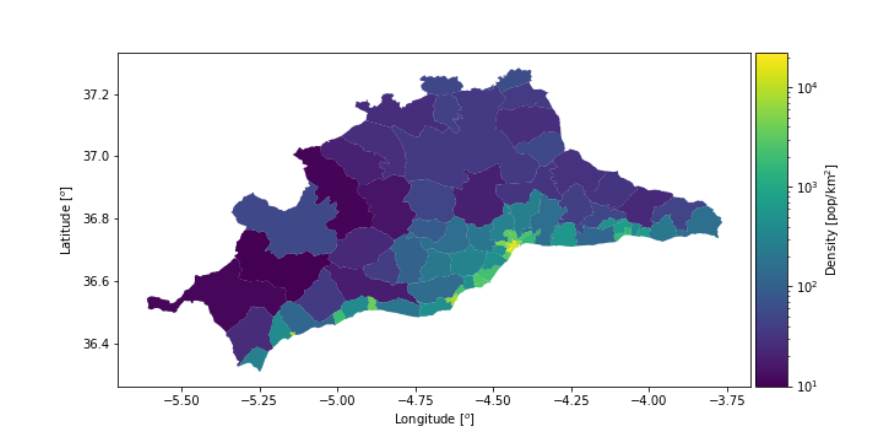
Figure 3. Population density in the province of Málaga.